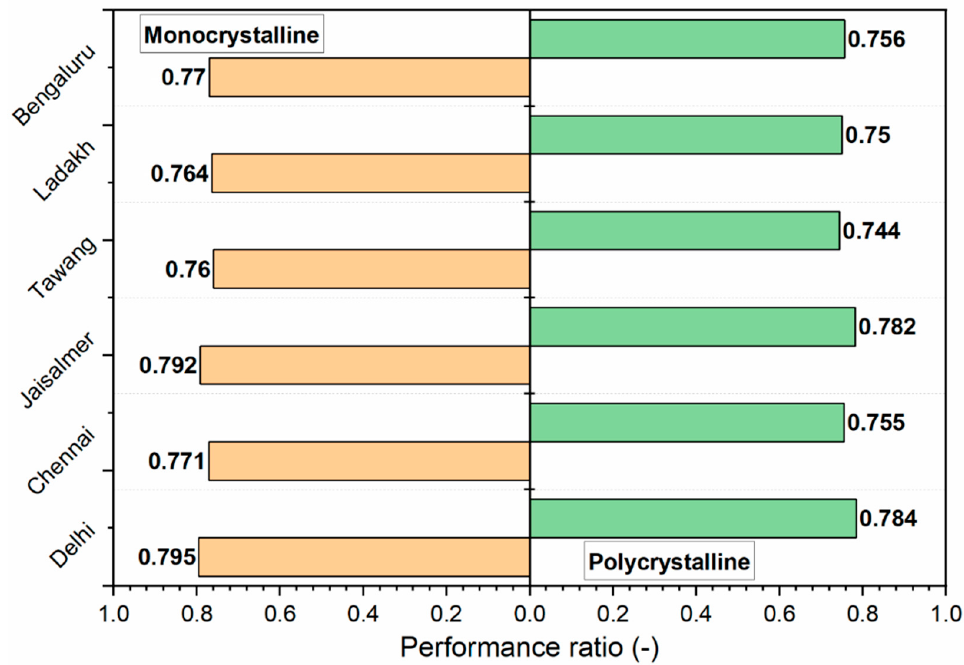
Figure 11. Performance ratio for the station in all six cities with different module technologies .